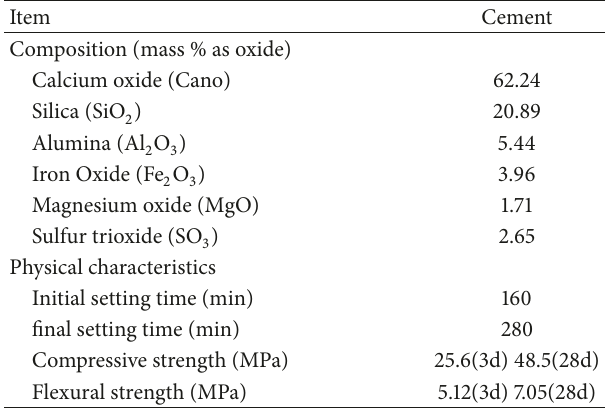
Table 1: Chemical composition and physical characteristics of ordinary Portland